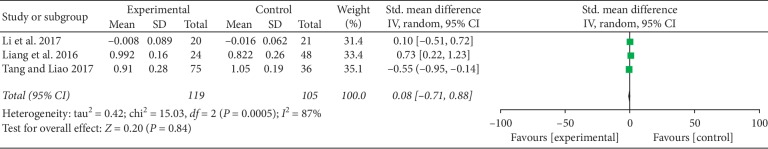
UCVA forest map after follow-up.